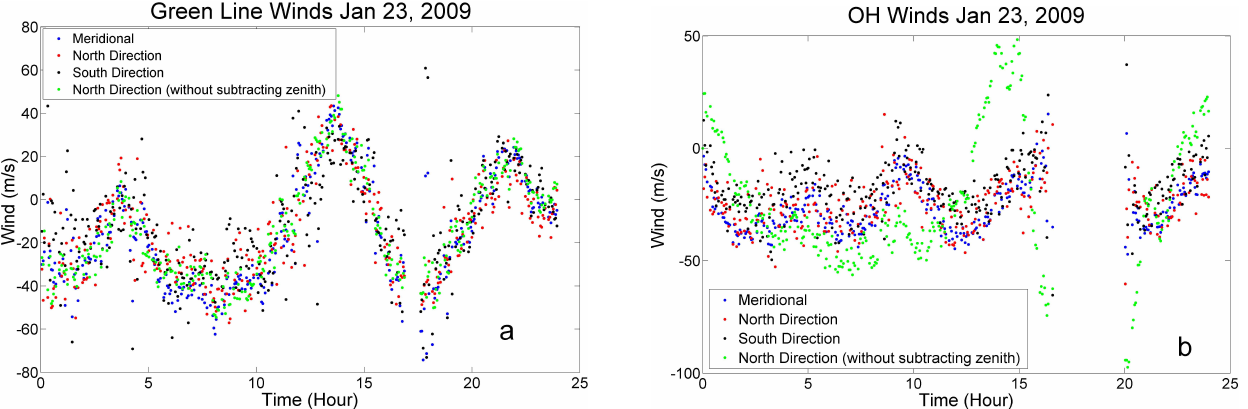
Fig. 9. Time series of meridional winds (ms − 1 ) from 23 January 2009 for the green-line (a) and hydroxyl emission (b) observations showing the consistency of the observations in the north and south directions when thermal drift and zero wind are appropriately accounted for and the problems – green points – in (b) when they are not. The standard errors of these observations are approximately the size of the points in the figure. Detailed discussion is in the text.